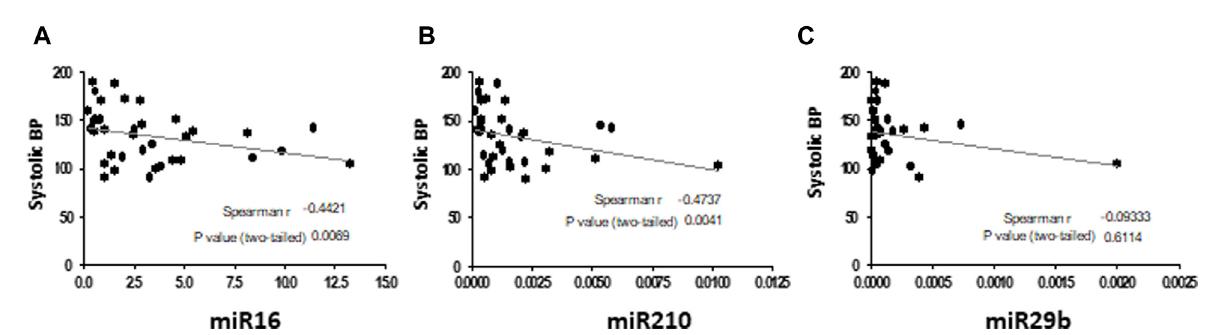
FIGURE 5 Correlations between systolic blood pressure (BP) in pregnant women (HP and with GVC) and EV pellet miRNA expression The graphs present Spearmantestcorrelations analysisbetweensystolicbloodpressureinthepregnantwomen(theHPandGVCgroupscombined)andexpressionlevelsof EV miRNA16 (A) , miRNA210 (B) and miR29b (C)